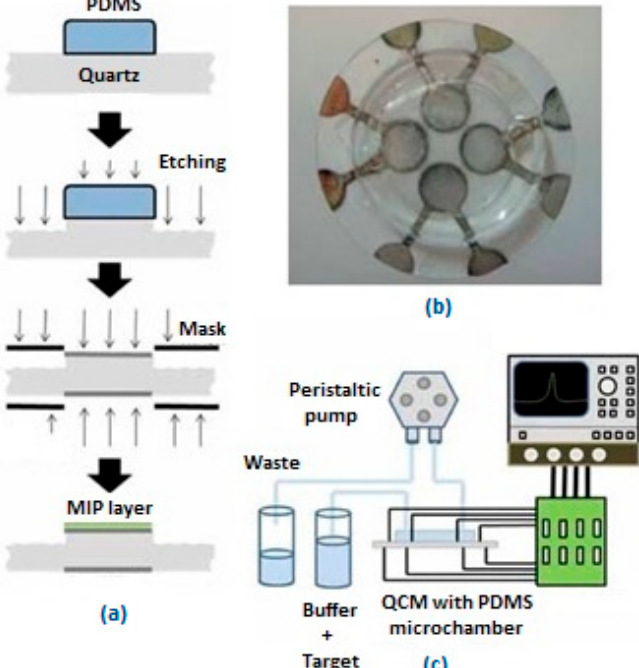
Figure 5. ( a ) Schematic demonstration of MIP-based QCM sensor; ( b ) Prepared MIP based-QCM sensor with multi-channel; ( c ) Schematic depiction of the prepared sensor system combined with impedance analyzer (reproduced with permission from [28]).